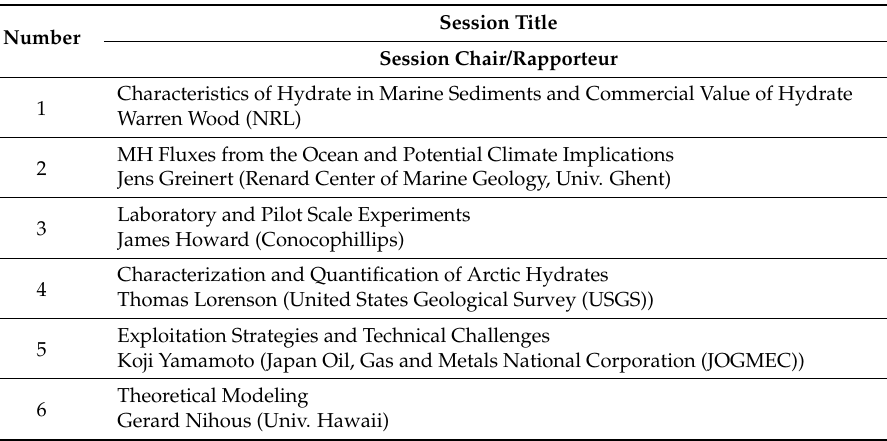
Table 7. Breakout sessions (title and chairs/rapporteur).